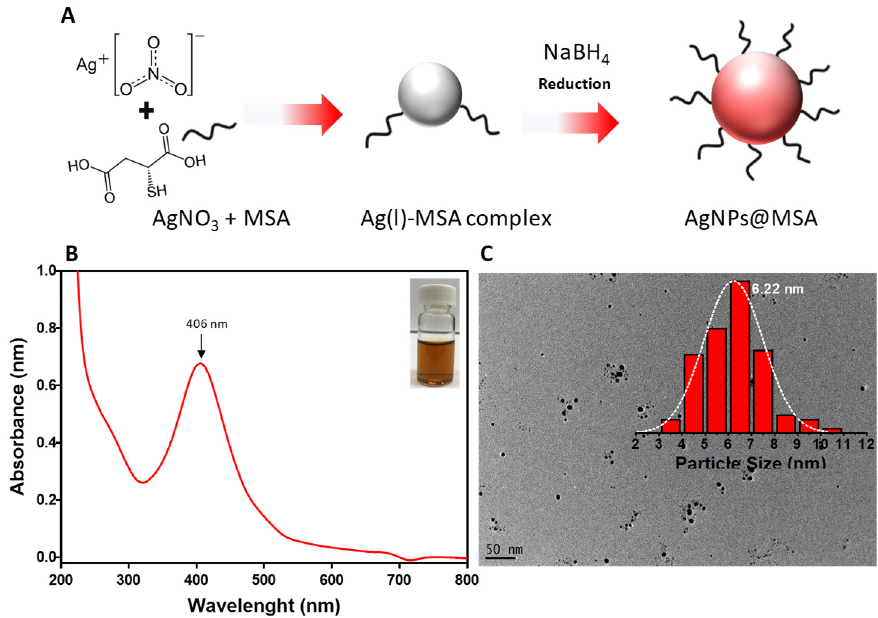
Figure 1. ( A ) Schematic illustration of AgNPs formation via chemical reduction. ( B ) UV–vis ab- sorption spectra of AgNPs; the inset is a photograph of the AgNPs@MSA solution. ( C ) TEM image of the AgNPs; the inset shows the nanoparticle size distribution.